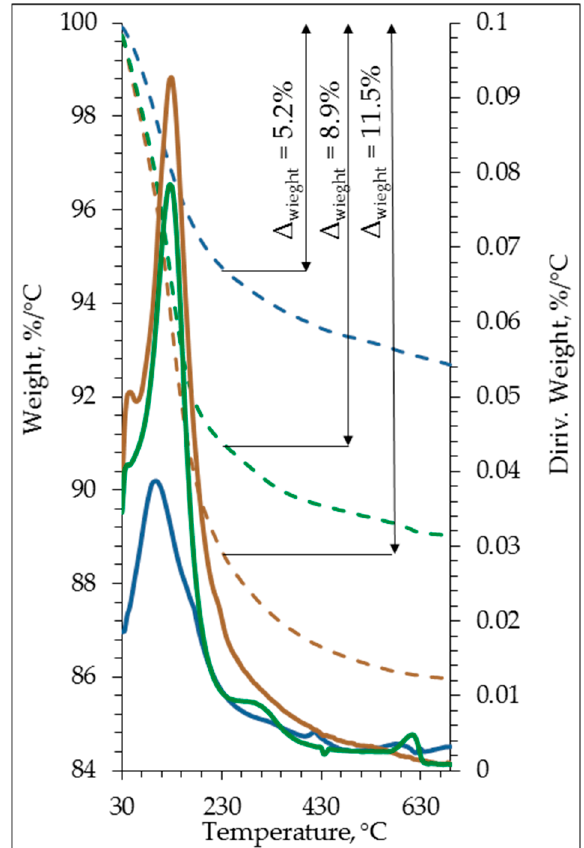
Figure 9. TG/DTG of obtained porous AAM (dashed—TG, solid—DTG): FA_0—blue, MK_0—brown, Figure 9. TG / DTG of obtained porous AAM (dashed—TG, solid—DTG): FA_0—blue, MK_0—brown, FA+MK_0—green. FA +